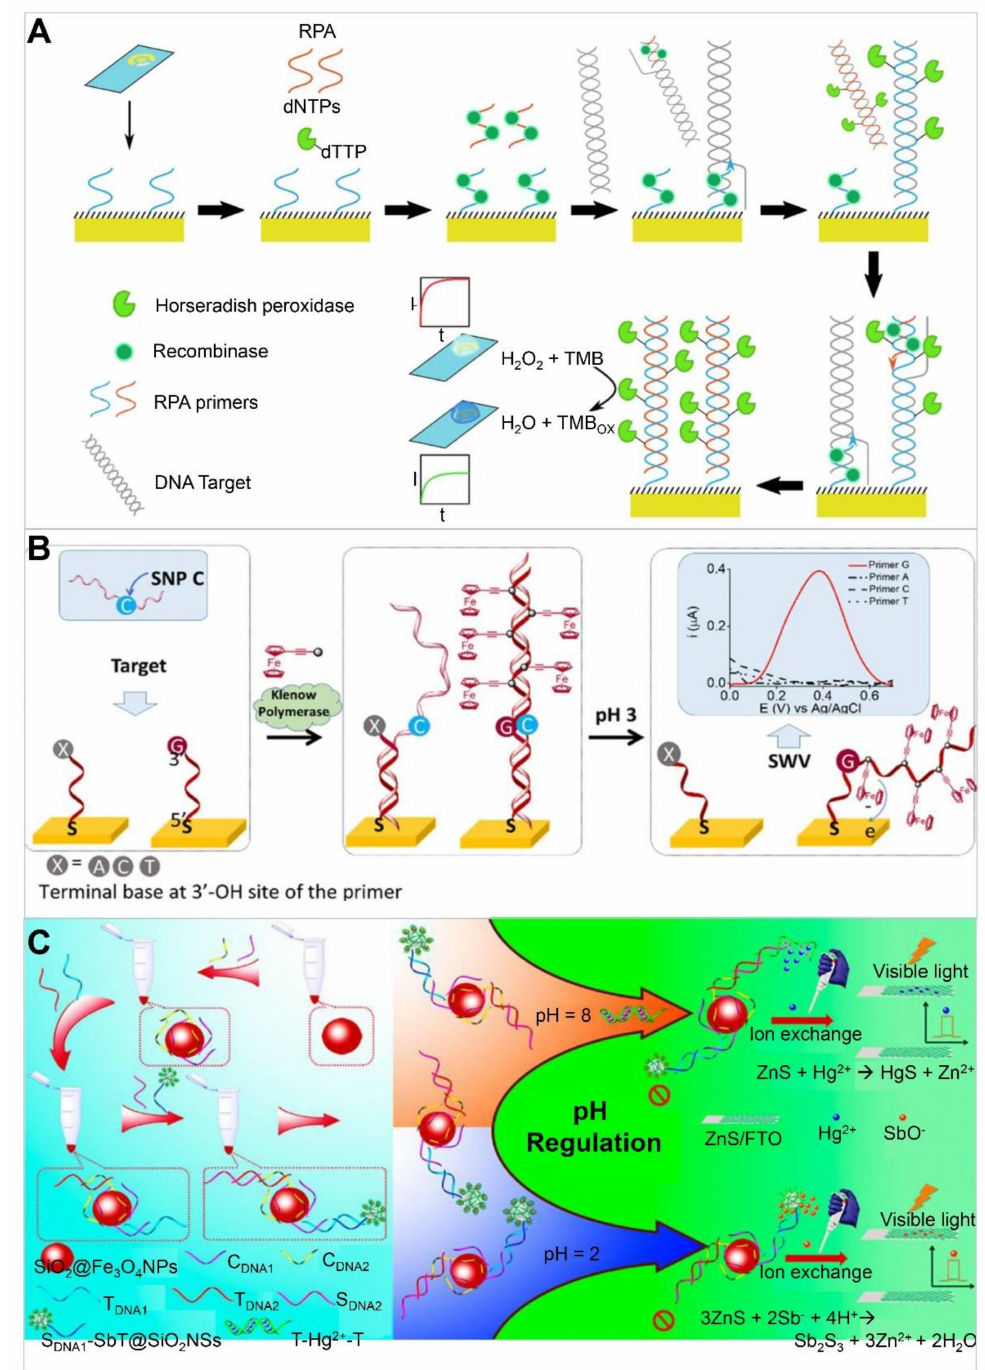
Figure 1. Electrochemical antibiotic susceptibility testing strategy based on the detection of antibiotic- resistant genes. ( A ) Isothermal amplification reaction-coupled screen-printed gold electrode for the detection of oxacillin-resistant genes in Escherichia coli . Adapted with permission form [47]. Copyright 2021 American Chemical Society; ( B ) Solid-phase primer elongation reaction-coupled gold electrode for the detection of rifampicin-resistant genes in Mycobacterium tuberculosis. Adapted with permission form [48]. Copyright 2021 American Chemical Society; ( C ) pH-controlled metal ion-embedded nanosphere-immobilized on the ZnS modified fluorine tin oxide (FTO) electrode for the detection of penicillin-resistant genes in E. coli . Adapted with permission form [49]. Copyright 2020 American Chemical Society. RPA, recombinase polymerase amplification; TMB, 3,3 (cid:48) ,5,5 (cid:48) -tetramethylbenzidine; SWV, square wave